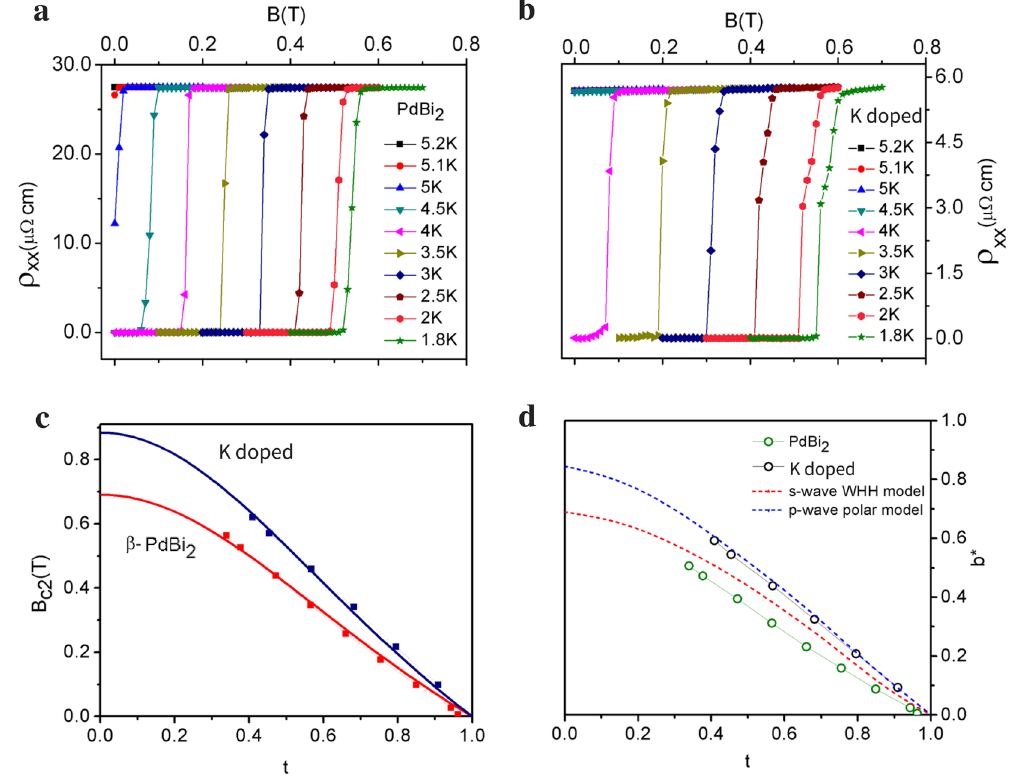
= B − t 2 )/(1 + t 2 ) is shown in red and blue for pristine 2 . ( c ) The fit to B c 2 ( t ) c 2 (0)(1 and K-doped β -PdBi 2 respectively. ( d ) Plot of the reduced upper critical field, b * = B c 2 /| dB c 2 / dt | t = 1 as a function of the reduced temperature t = T / T c . The red dash is the upper-limit for s-wave superconductivity